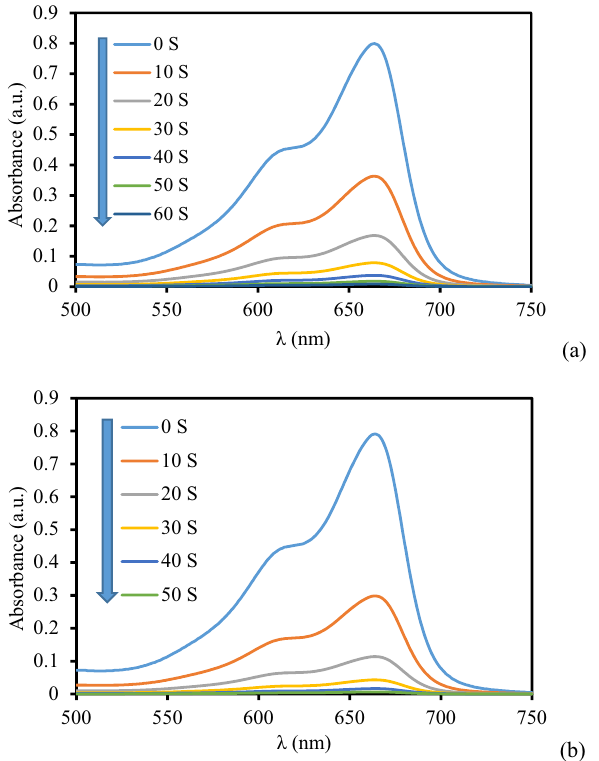
Figure 8. The absorption profile in the reduction of MB using 2 mg ( a ) and 3 mg ( b ) of KIT-5- biguanidine-Au(0) nanocomposite.